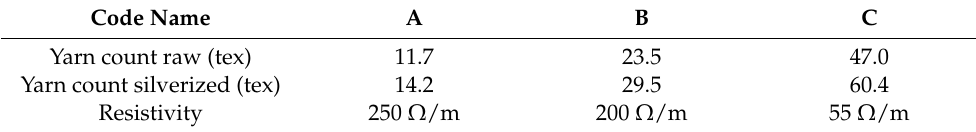
Table 1. Characteristic parameters of the electroconductive yarns.